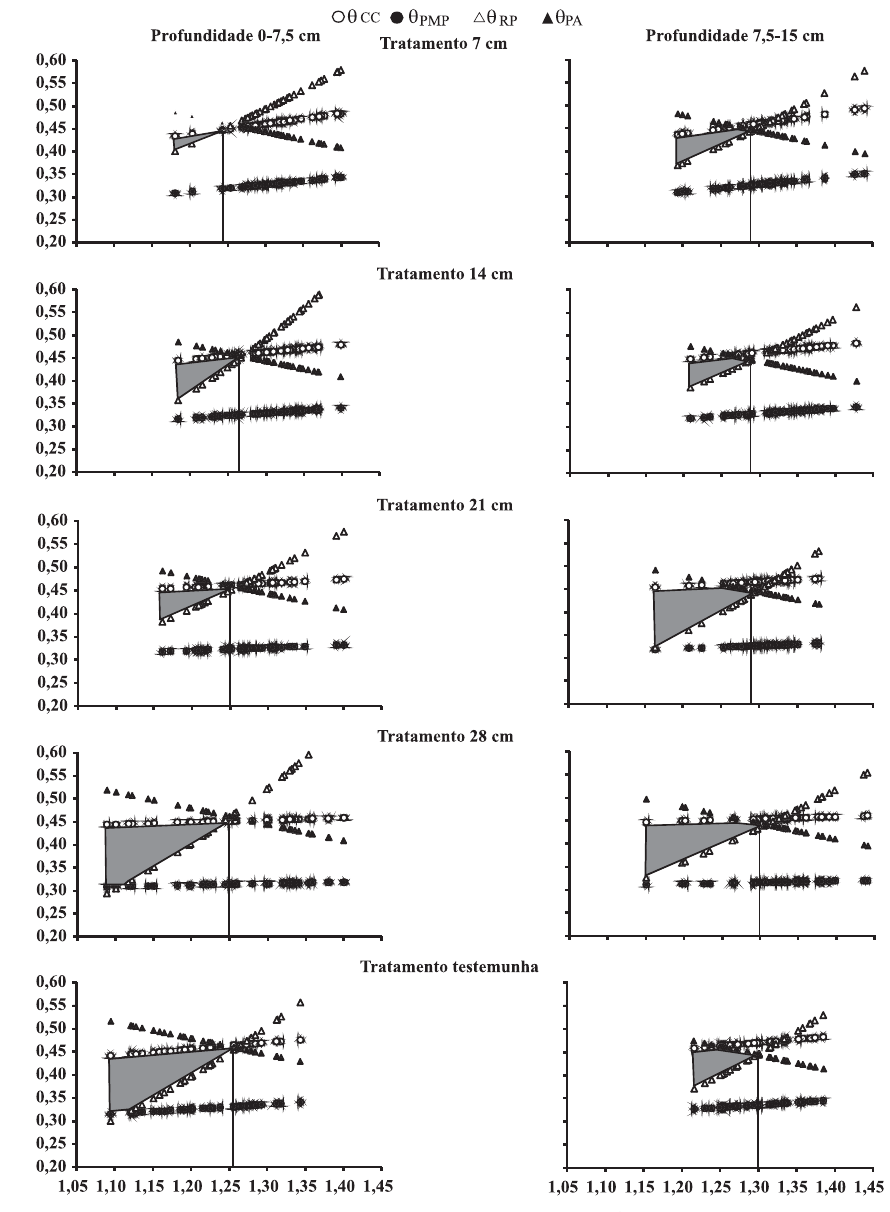
Figura 1. Variação do conteúdo de água com a densidade do solo nos níveis críticos da capacidade de campo ( θθθθθ ), ponto de murcha permanente ( θθθθθ CC nas camadas de 0–7,5 e 7,5–15 cm de profundidade e nos tratamentos com 7, 14, 21 e 28 cm de altura de pastejo e testemunha sem